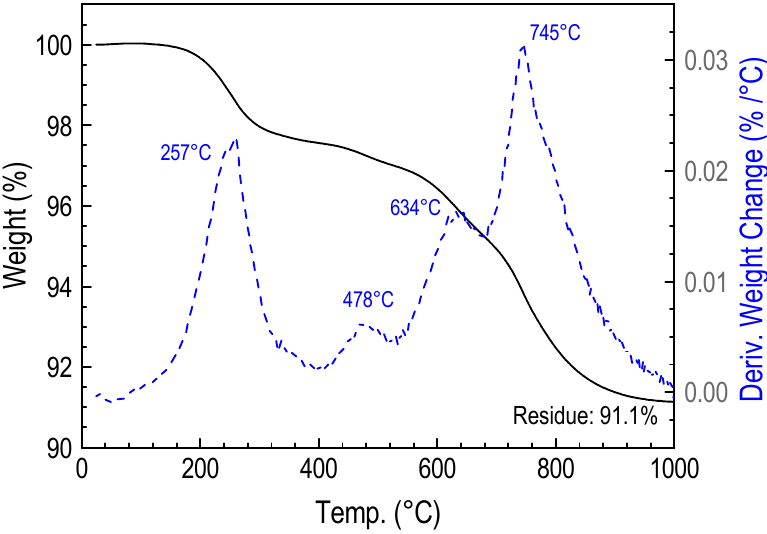
Figure 8. TGA curve of the thin film #4 90 min post-bake at 150 °C in air.